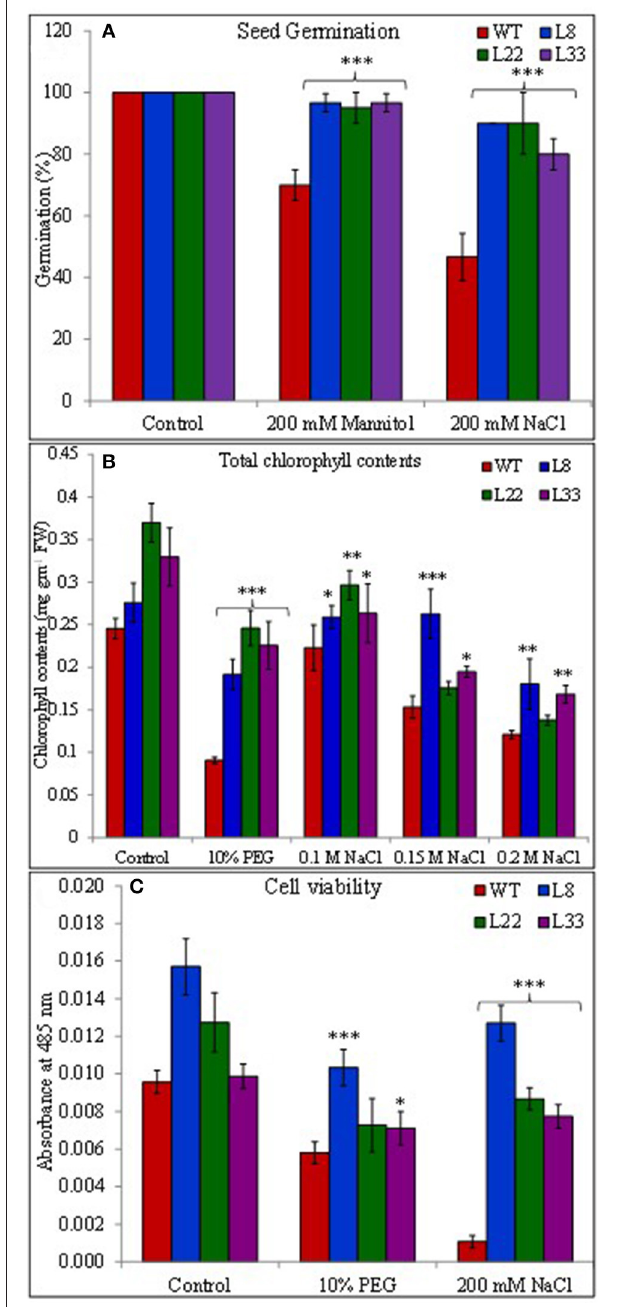
FIGURE 2 | Seed germination in WT and transgenic lines under mannitol and NaCl stress after 21 days (A) , total chlorophyll contents (B) , and cell viability assay (C) of WT and transgenic tobacco under control and stress (PEG and NaCl) conditions for 7 days. The *, **, and *** denote statistical significance in responses of transgenic lines against control at P value ≤ 0.05, 0.01, and 0.001 respectively.